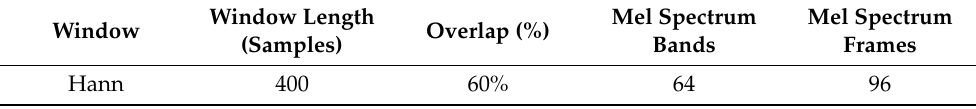
Table 2. Mel spectrogram extraction for YAMNet